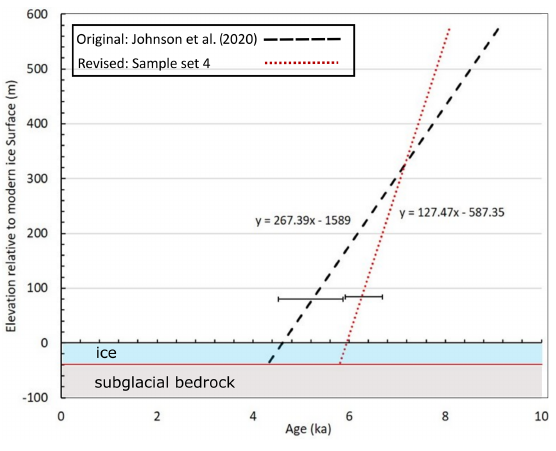
Figure 8. Predicted timing of exposure at or near the surface of subglacial bedrock cores drilled at Kay Peak ridge. Predictions of timing for bedrock exposure extrapolated from the two endmem- ber best-fit linear thinning rate scenarios calculated from different input combinations of exposure ages. The best-fit ice surface low- ering rate is determined from the published Mt. Murphy exposure age dataset of Johnson et al. (2020) and is contrasted with the best fit from the revised dataset (sample set 4), which includes exposure ages from the scoria cone and omits KAY-105 and KAY-109. Error bars represent 95% confidence intervals of best-fit timing at which the samples closest to the modern ice surface were deglaciated. Be- low the 95% confidence bars, the best-fit line has been extrapolated based on the linear equations shown in the figure. The shaded blue area represents the ice thickness that was drilled ( ∼ 40m) to reach the subglacial bedrock. The red horizontal line is a one-dimensional representation of the bedrock surface at the point of core recovery. Note the 95% confidence interval of revised best-fit timing of end of thinning is at a slightly higher elevation (84m) because KAY- 105 is the sample at Mt. Murphy closest to the modern ice surface